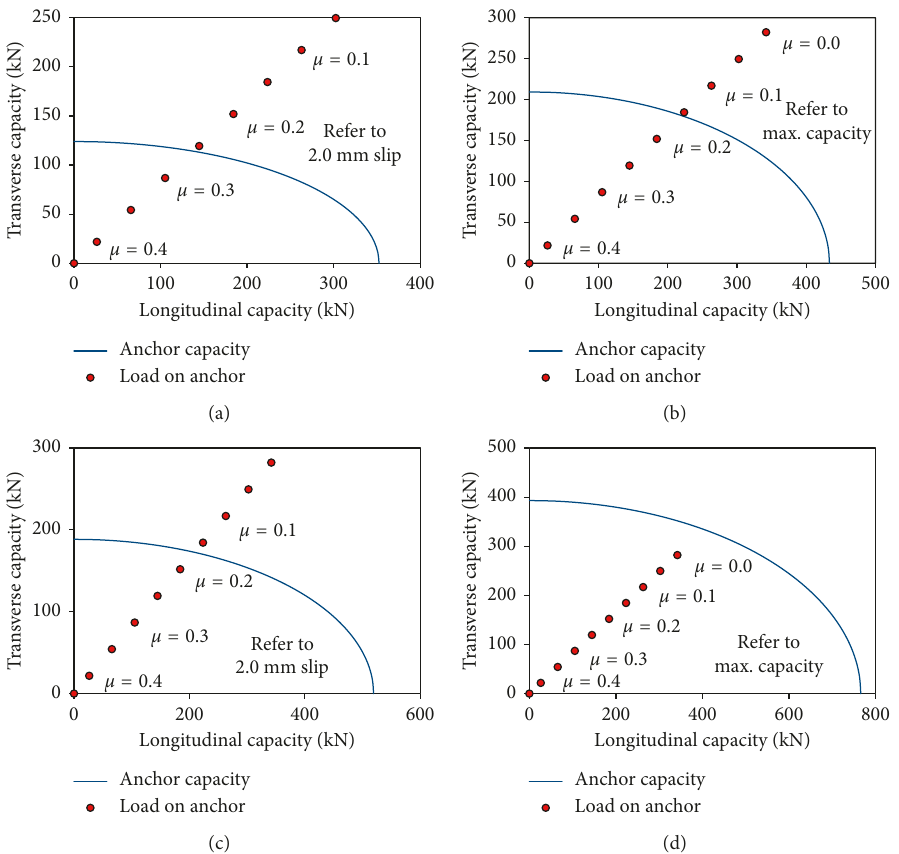
Figure 16: Investigation on structural safety considering friction coefficient and biaxial shear: (a) Design A with design loading capacity, (b) Design A with ultimate loading capacity, (c) Design B with design loading capacity, and (d) Design B with ultimate loading